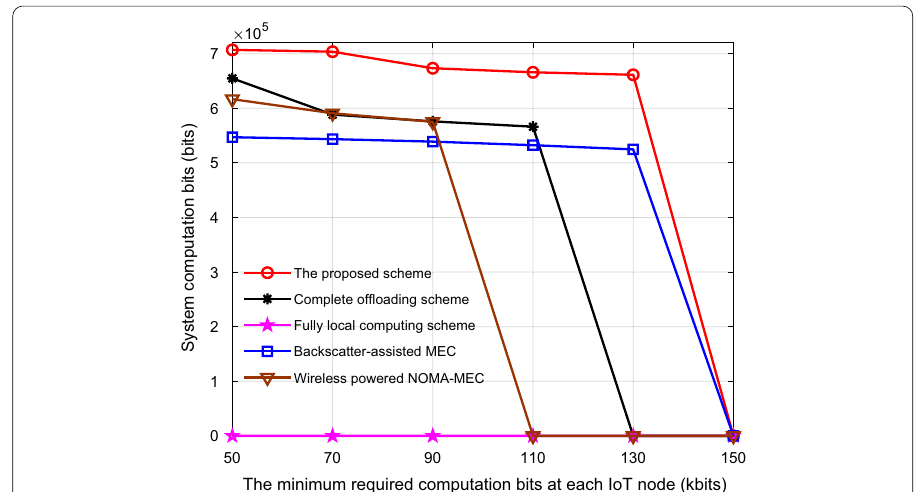
Fig. 4 System computation bits versus the minimum required computation bits at each IoT node